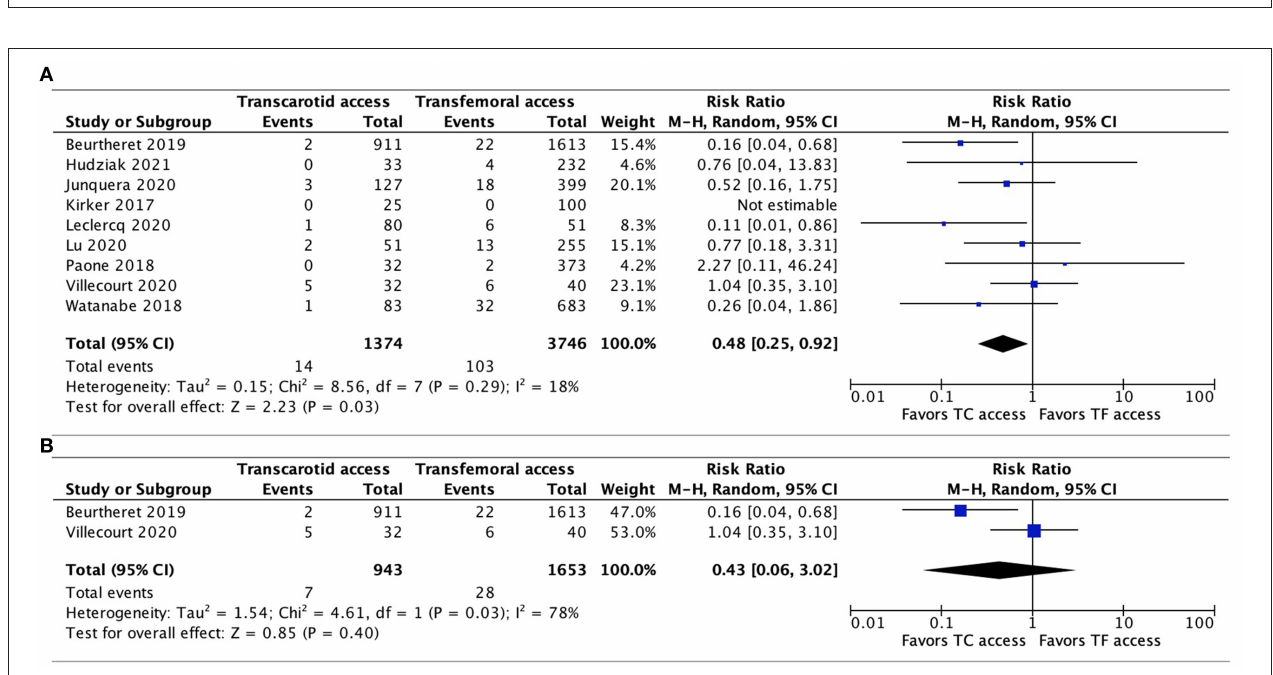
FIGURE 3 | Forest plots comparing neurovascular complications at 30 days between TC and TF transcatheter aortic valve replacement procedures. (A) Pooled data from all studies. (B) Pooled data from propensity-score matched studies. TC, transcarotid; TF, transfemoral.